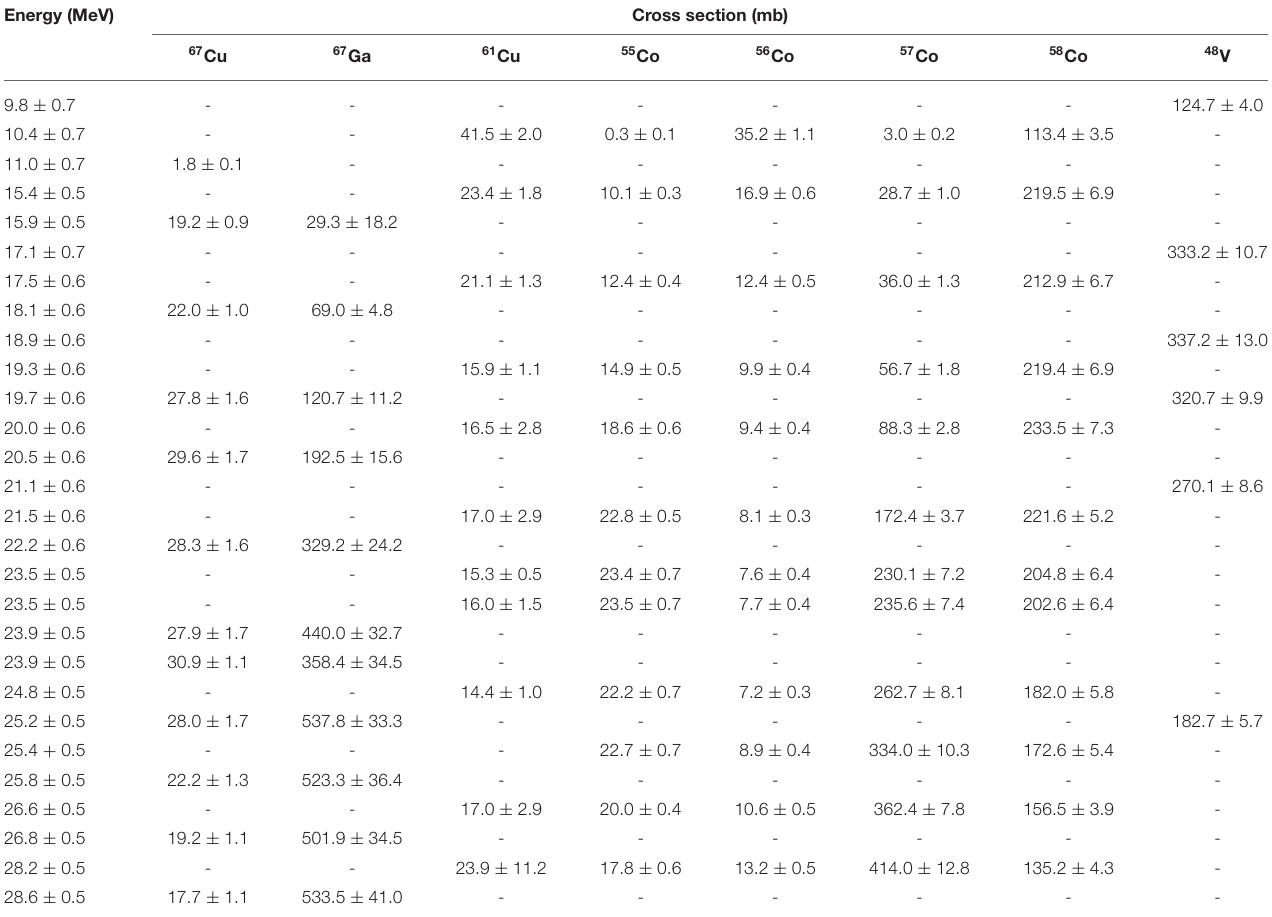
TABLE 1 | Cross section values measured in this study for reactions having taken place in zinc, nickel, and titanium. Energy